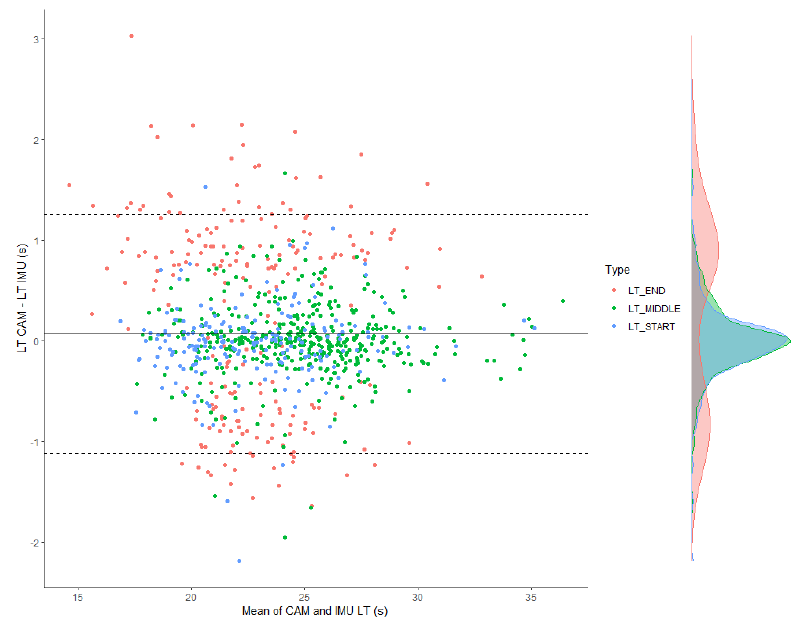
Figure 4. Statistical agreement between gold standard lap times and IMU lap times per type of lap